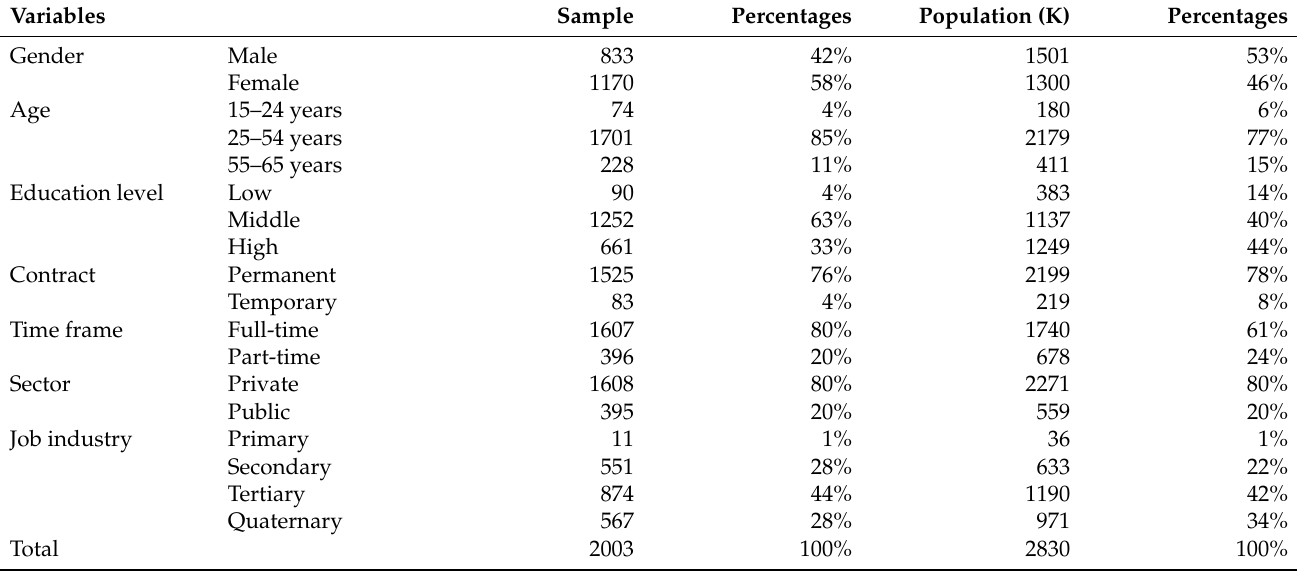
Table A2. Sample vs. Flemish population; source: Statistics Belgium (www.statbel.fgov.be: accessed on 28 August 2020).